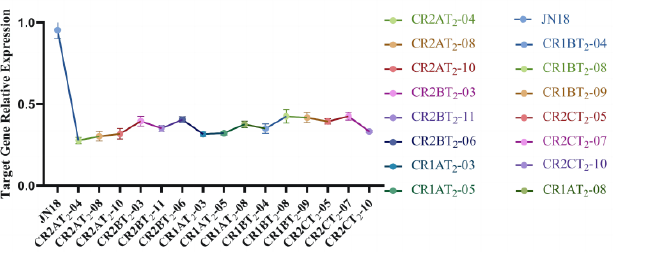
Figure 10. Expression of target gene in gene editing positive plants. All data shown are means ± SD of three biological replicates. of three biological